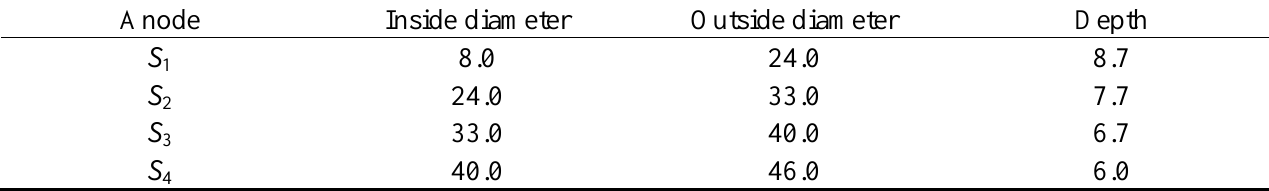
Table 2. The geometrical sizes of the steel anode rings used in this study